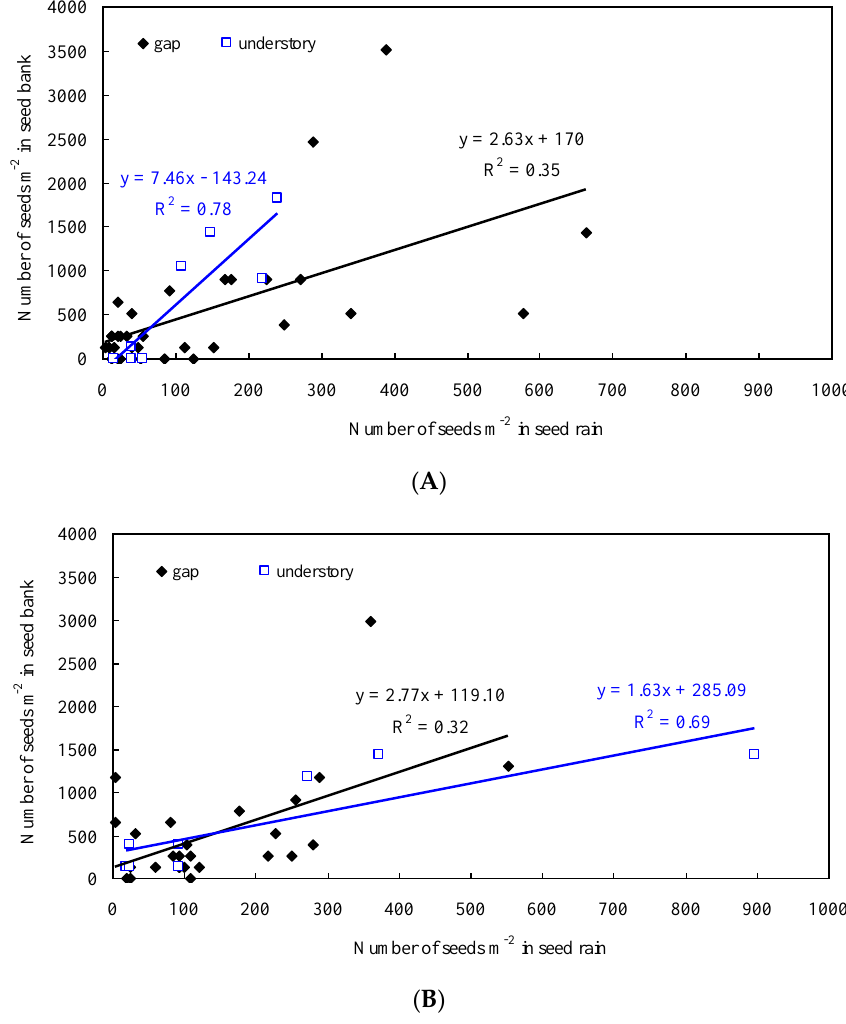
Figure 4. Relationship between the seed density of seed rain and that of the soil seed bank for all types of tree species in large gaps ( A ) and medium gaps ( B ).